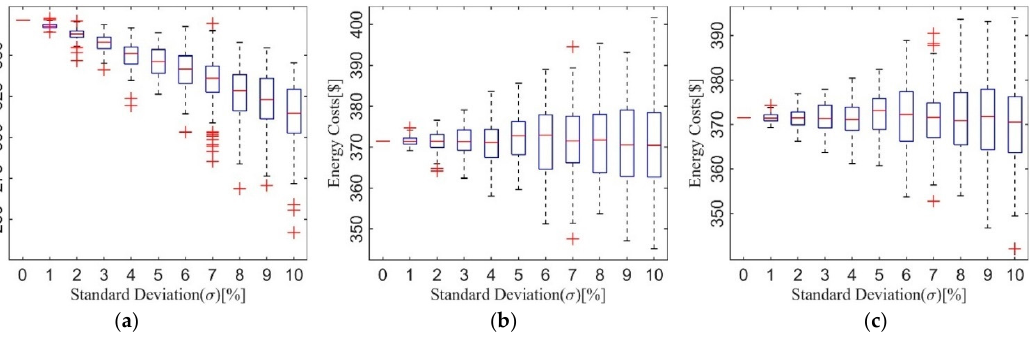
Figure 7. Distribution of Energy Costs: ( a ) Price-guided Case; ( b ) Loss-guided Case; ( c ) Random Case.